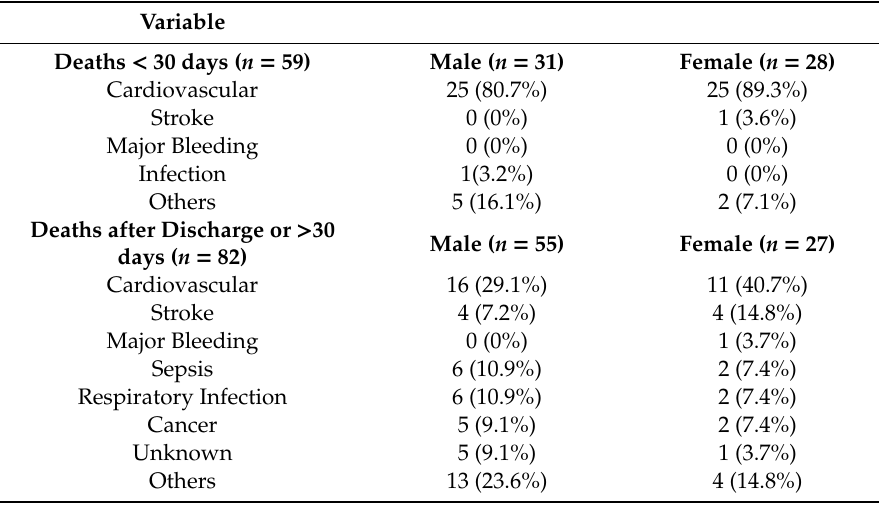
Table 3. Causes of